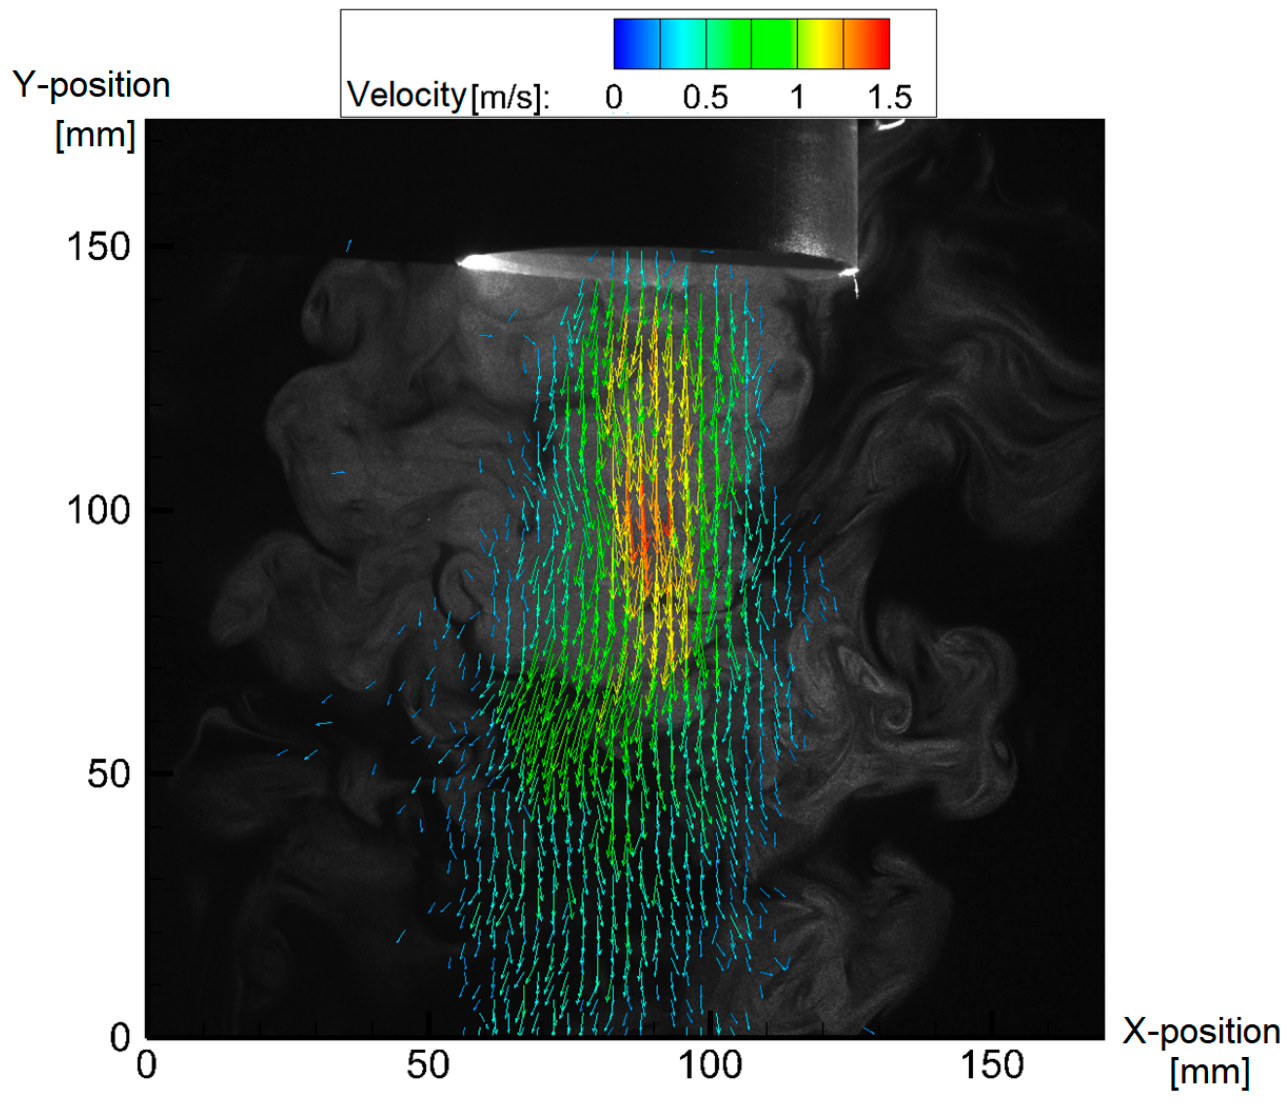
Figure 9. Flow velocity vector map measured using the PIV method on the bottom end of the EHD generator ( a = 80 mm, g = 10 mm) connected to the working voltage U = 16 kV.